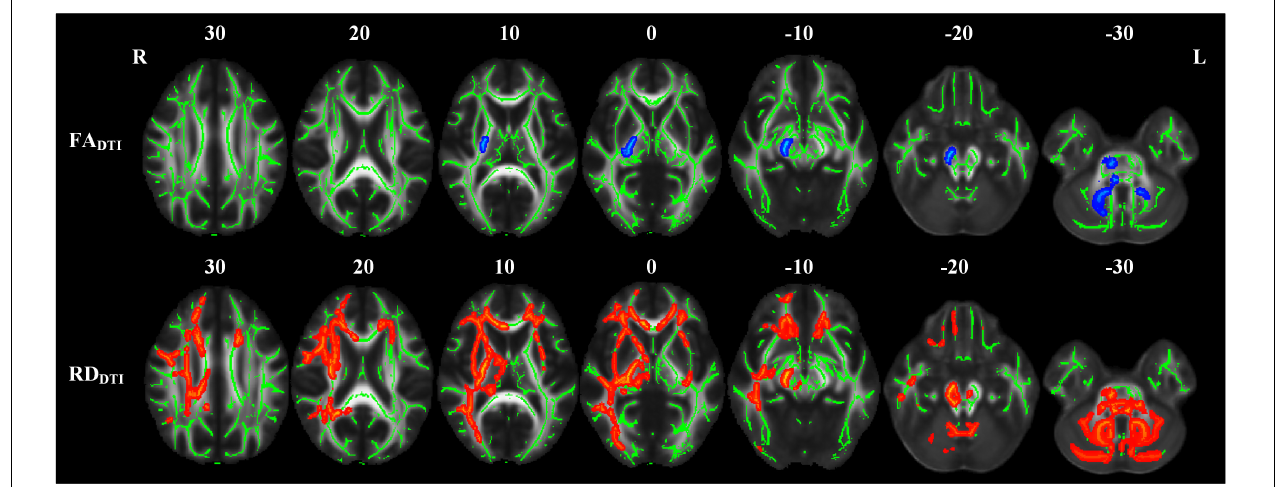
FIGURE 3 | TBSS analyses showed abnormal white matter tracts in the RPI group with DTI-derived parameters. Red indicated white matter tracts with significantly increased parameter values and blue indicated white matter tracts with significantly decreased parameter values. Green represented the mean FA skeleton of all subjects. L and R, left and right; FA, fractional anisotropy; MD, mean diffusivity; RD, radial diffusivity; TBSS, tract-based spatial statistics; DTI, diffusion tensor imaging. TABLE 3 | Abnormal white matter fibers derived DTI different parameters in RPI group compared with NC group. Group Parameters Cluster MNI index